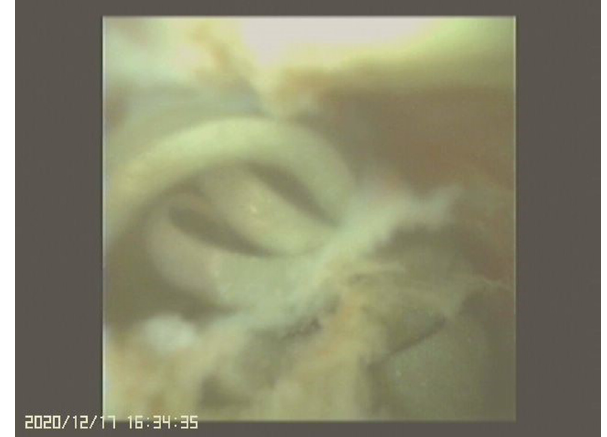
Figure 4: The video image of fURS and the coiled element.